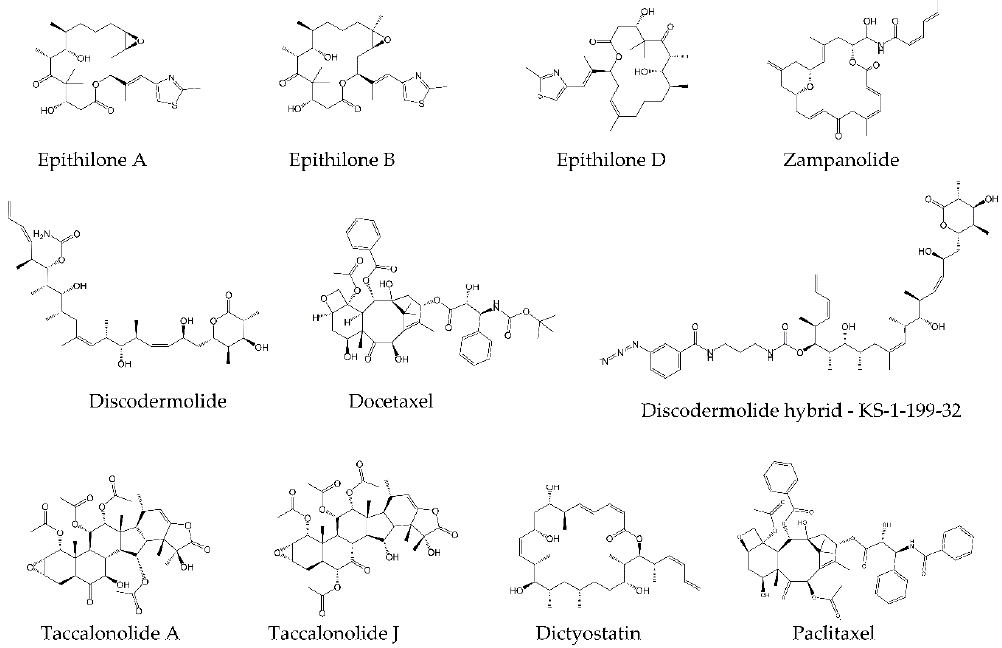
Figure 3. Structure of docetaxel; epothilones A, B, and D; discodermolide (DDM),